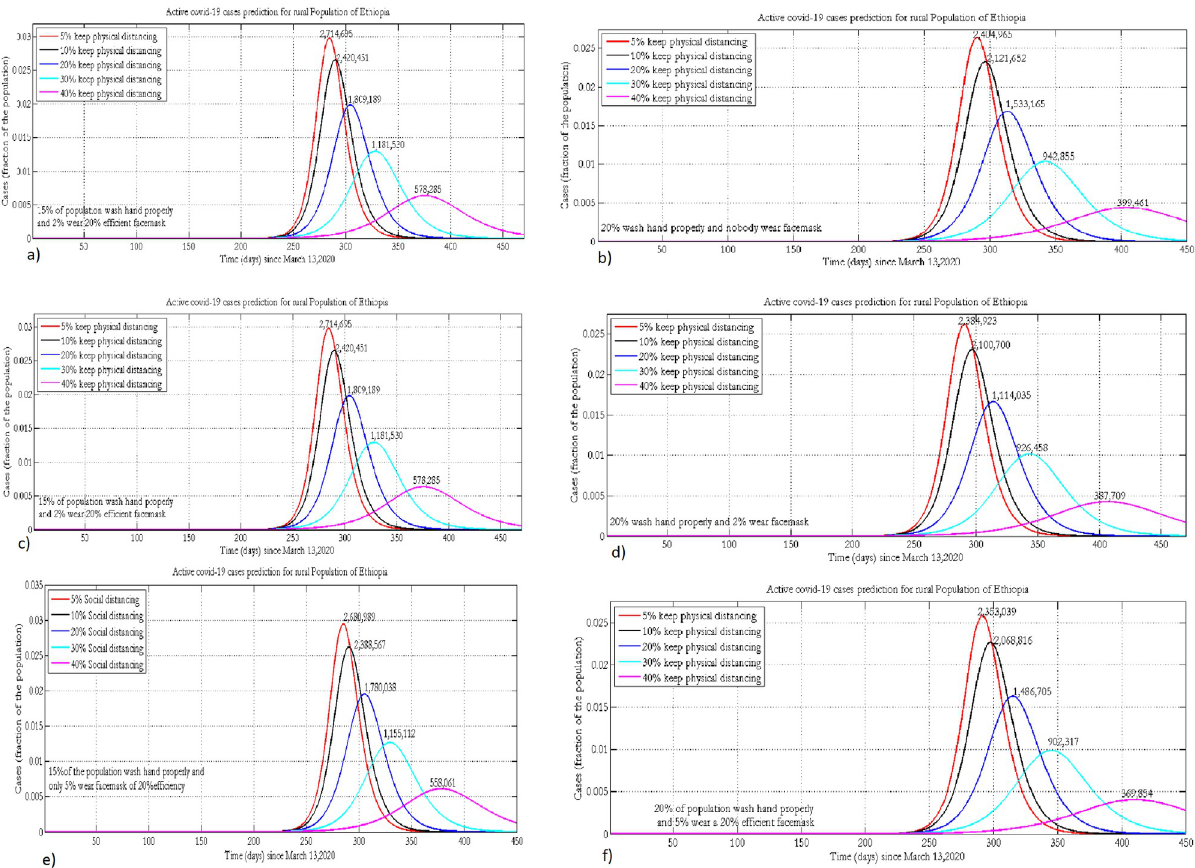
Fig 3. Projection of active COVID-19 cases in the rural population of Ethiopia where 15% or 20% practice hand washing and 0% (a, b), 2% (c, d) or 5% (e, f) of the population wear face masks, with 20% efficacy.